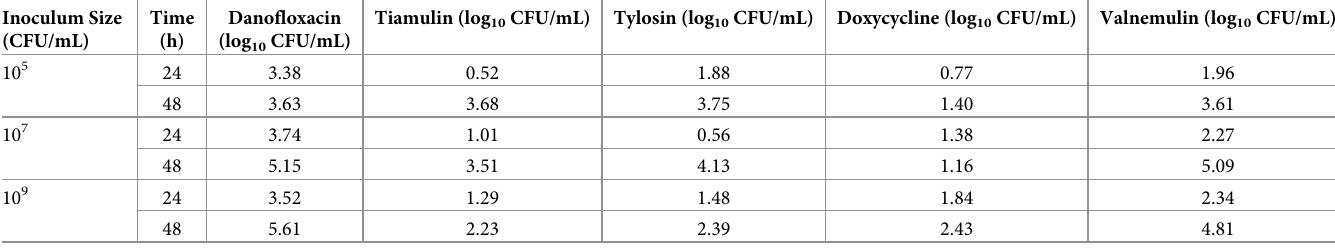
Table 2. Reduction in M . hyopneumoniae growth for three different inoculum sizes based on measured MIC 99 concentrations. Inoculum Size